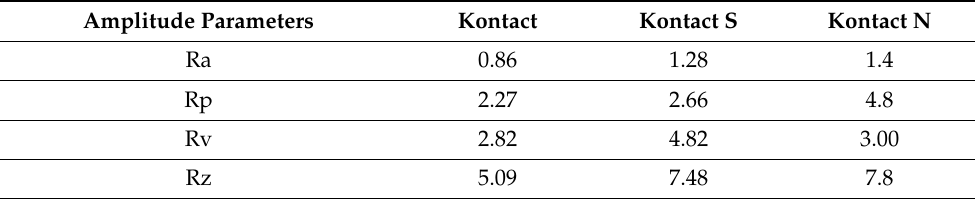
Table 1. Roughness measurement of the dental implants estimated through the amplitude parameters Ra, Rp, Rv, Rz taken with Leica